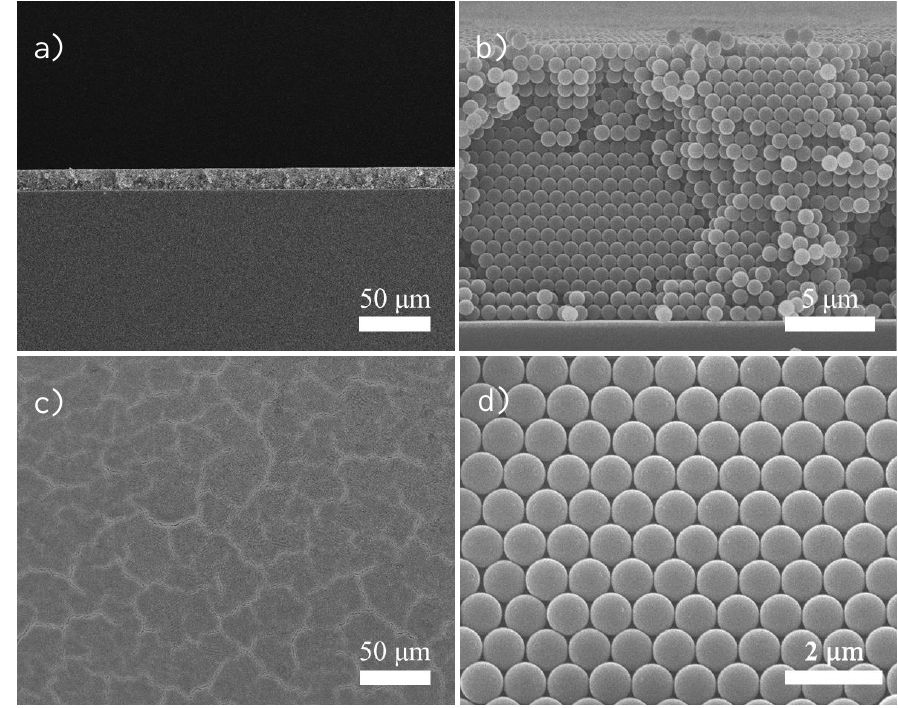
Figure 1. The SEM images for polystyrene (PS) colloidal crystals in cross-sectional view; ( a ) low magnification and ( b ) high magnification, as well as in top view; ( c ) low magnification and ( d ) high magnification.